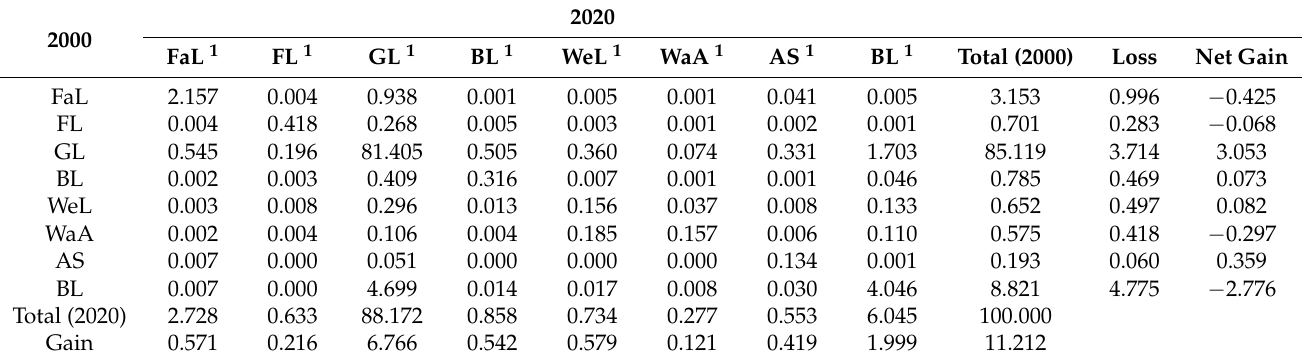
Table 3. The Xilin Gol League land transfer matrix from 2000 to 2020